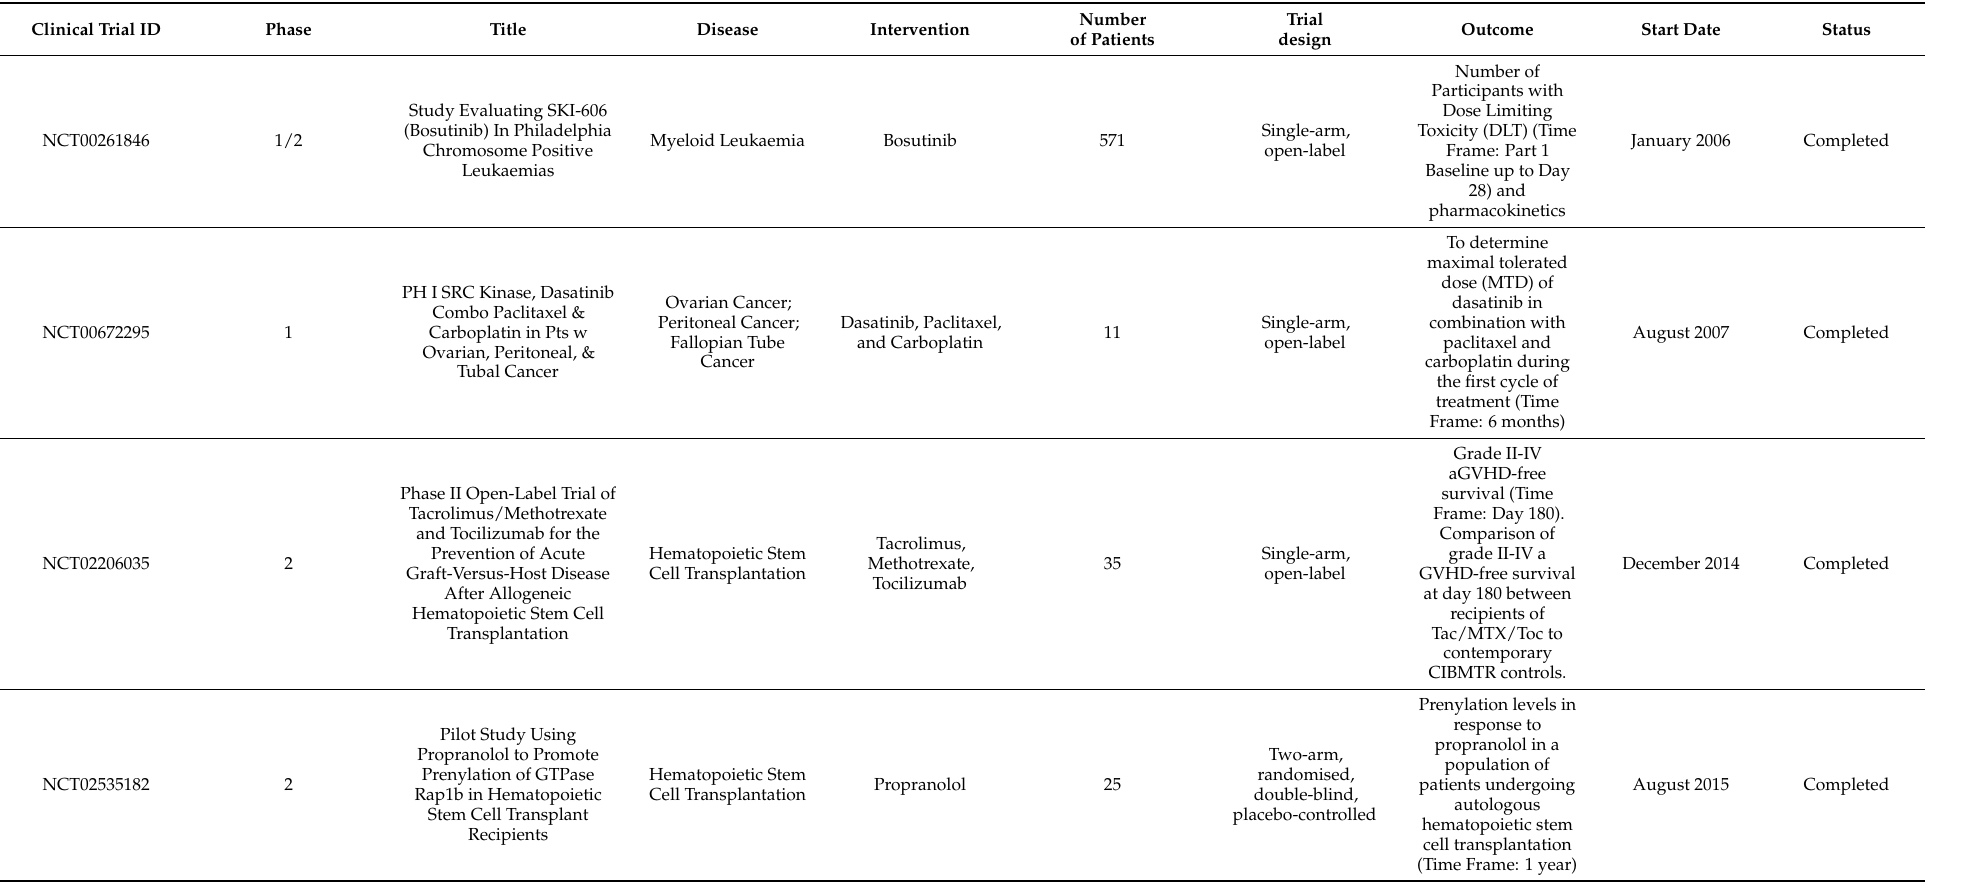
Table 2. Compilation of the interventional clinical trials registered studying molecules involved in C3G signalling